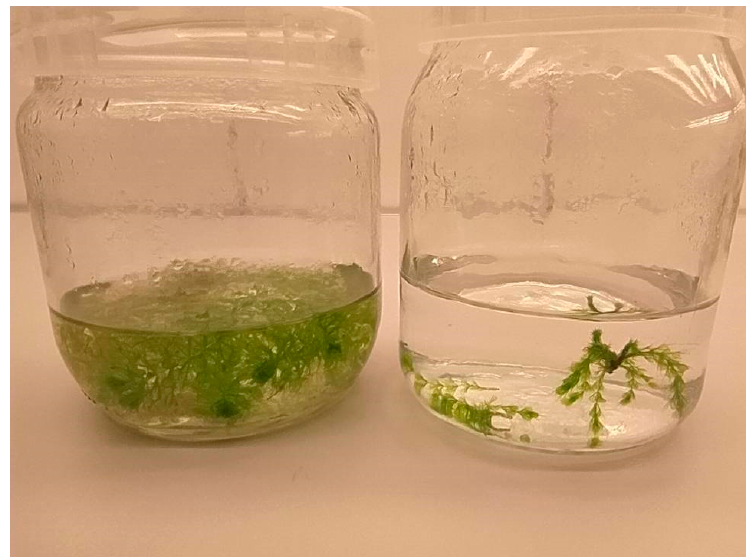
Figure 4. Subsequent influence of the AgNPs 1/5 MS media supplementation on the Aldrovanda vesiculosa morphological features of shoots after the third 8-week passage in the AgNPs-free me- dia.